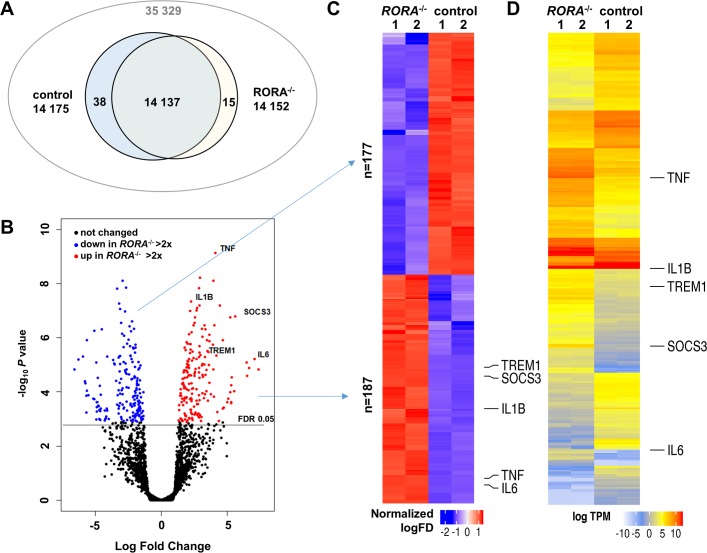
Deletion of RORA changes gene expression in differentiated THP-1 cells.A. Reads mapped to the human transcriptome were summarized for 35329 annotated genes. After filtering out genes with low read counts the remaining 14190 genes were used in differential expression analysis. B. Volcano plot shows distribution of raw p-values of identified 187 genes downregulated >2 fold in RORA-/- cells (blue) and 177 2-fold upregulated genes (red). C. Heatmap of 364 identified differentially expressed genes clustered by the overall expression levels. D. Heatmap of differentially expressed genes clustered by normalized read counts.